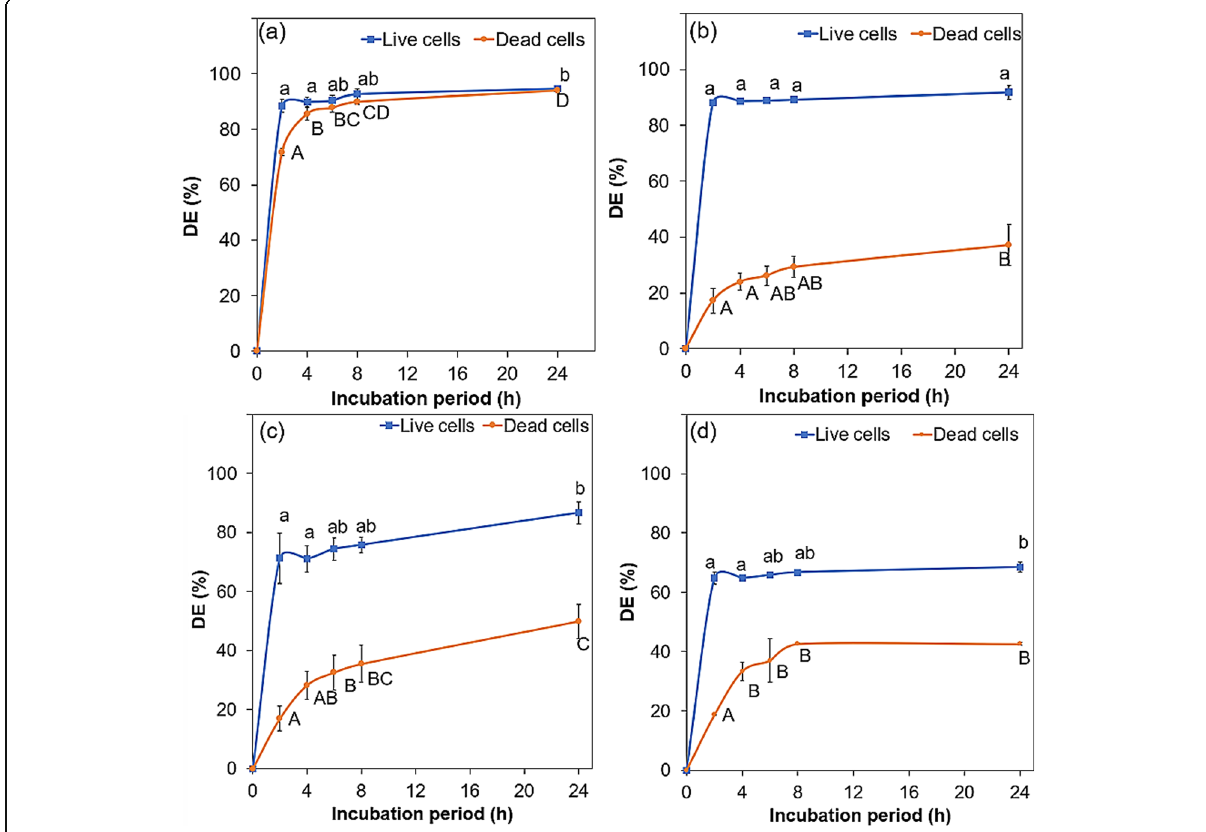
Fig. 10 Decolorization of (a) MG, (b) MV, (c) CV and (d) CB by Streptomyces isolate (live and dead cells) at combined optimized conditions throughout the incubation period. Means with the same small letters (live cells) and the same capital letters (dead cells) are not significantly different at HSD ( 0.05 ). Bars indicate ±